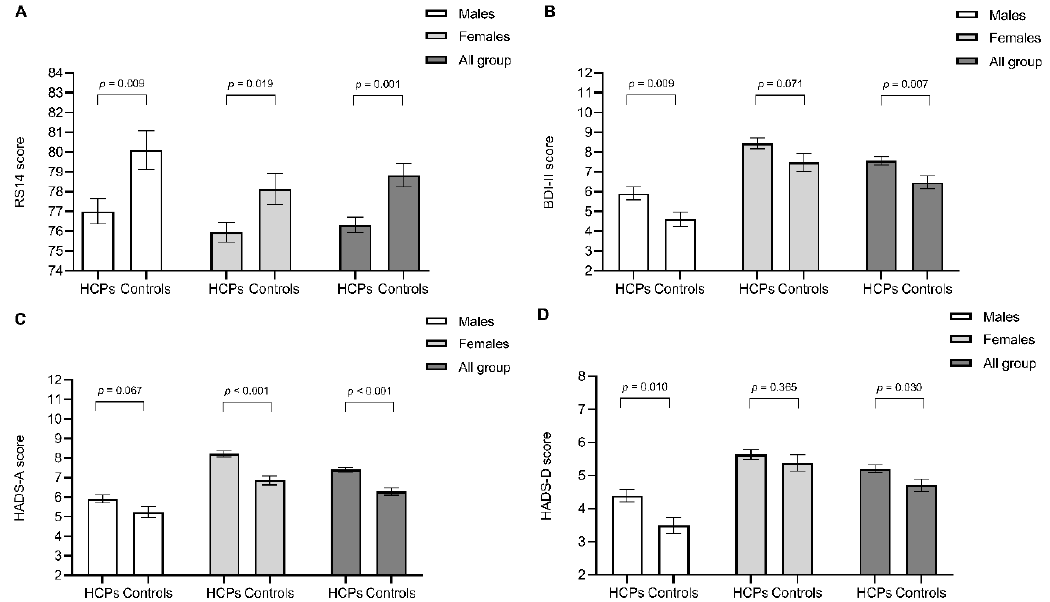
Figure 1. Resilience ( A ), depression ( B , D ), and anxiety ( C ) in healthcare professional (HCP) compared to control group. Data are expressed as mean and standard error of the mean and are stratified according to gender. RS14: 14-item Resilience Scale; BDI-II: Beck Depression Inventory-II scale; HADS-A: Hospital Anxiety and Depression Scale-Anxiety; HADS-D: Hospital Anxiety and Depression Scale-Depression.